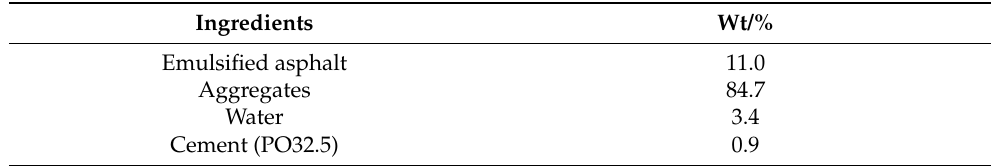
Figure 3. Aggregate gradation of micro surfacing. Table 3. Mixing proportion of micro surfacing